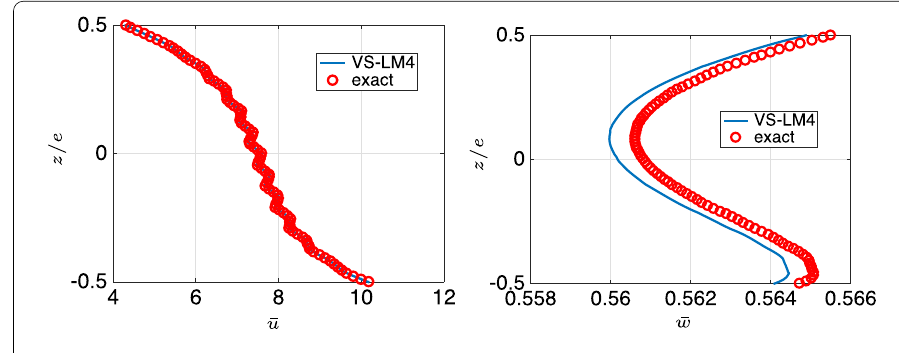
Fig. 6 Distribution of ¯ u (left), and ¯ w (right) along the thickness—S=4–24 layers— φ = π/ 3